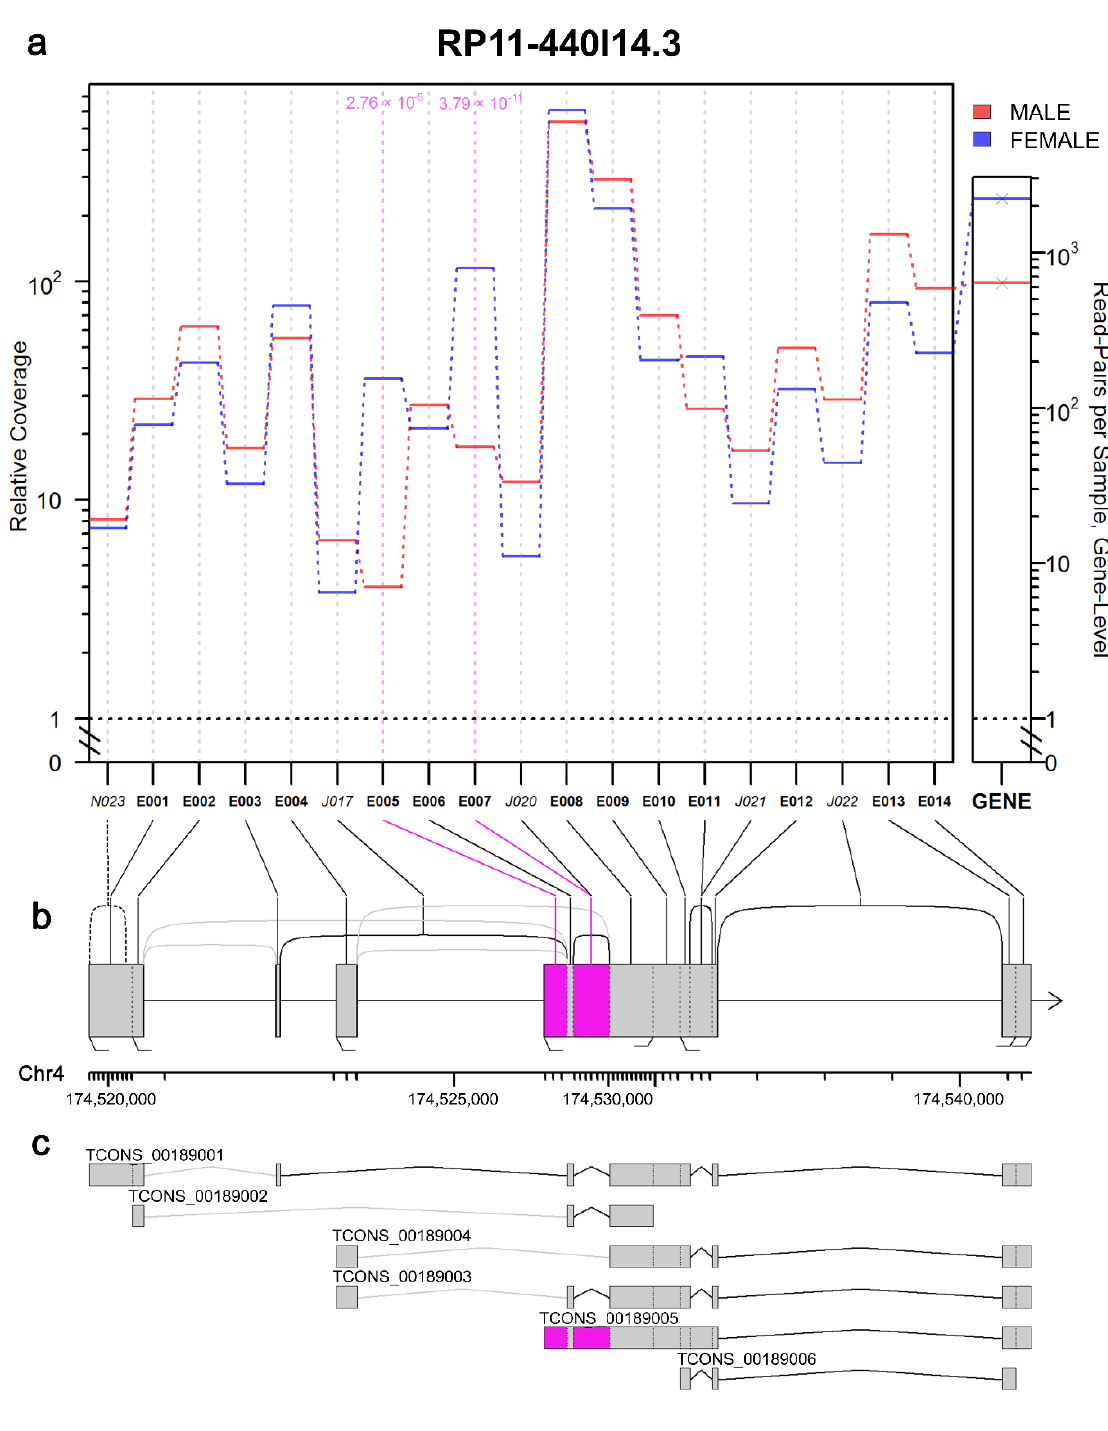
Figure 6. Presentation of differential transcript usage: ( a ) JunctionSeq gene profile plot for RP11-440I14.3 lncRNA identified in male (red) and female (blue) placental samples. This plot displays estimates for the mean normalized read-pair coverage count for each exon and splice junction. The small panel on the far right displays the total mean normalized read-pair count based on gene level. ( b ) Gene diagram displaying the exonic regions (boxes, labeled E001 – E014), known splice junctions (solid lines, labeled J017 – J022), and novel splice junction (dashed line, labeled N023) for RP11-440I14.3 lncRNA localized on chromosome 4 (Chr4). ( c ) The panel shows exon-intron structures of RP11-440I14.3 variants. Statistically significant differences ( p -adjust < 0.05) in exon usage are marked in pink.